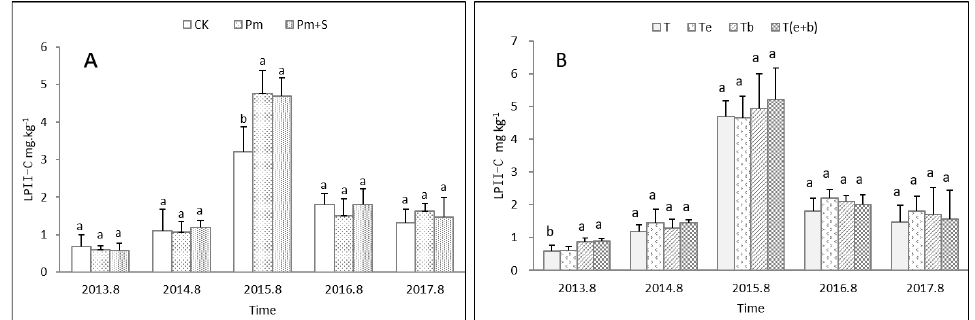
Figure 5. Dynamic change of soil organic carbon content (active component I) extracted by weak acid. Bars represent standard errors. Lower case letters above each panel show statistical signif-icance at p < 0.05. CK pig manure, S slurry, e earthworms, b bacteria, T Pm + S, Te T + earthworms, Tb T + bacteria, T(e + b) T + earthworms + bacteria ( A ) Pig manure, biogas slurry agricultural use ( B ) Biological control.